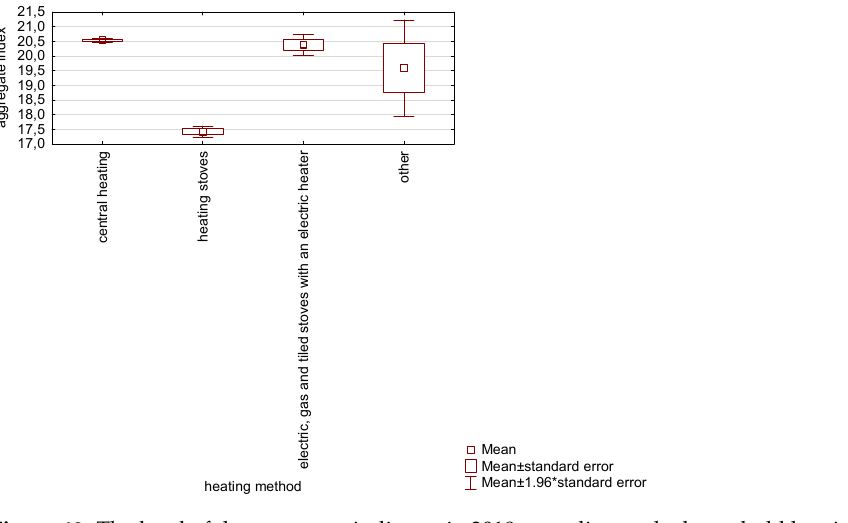
Figure 12. The level of the aggregate indicator in 2018 according to the household heating method of